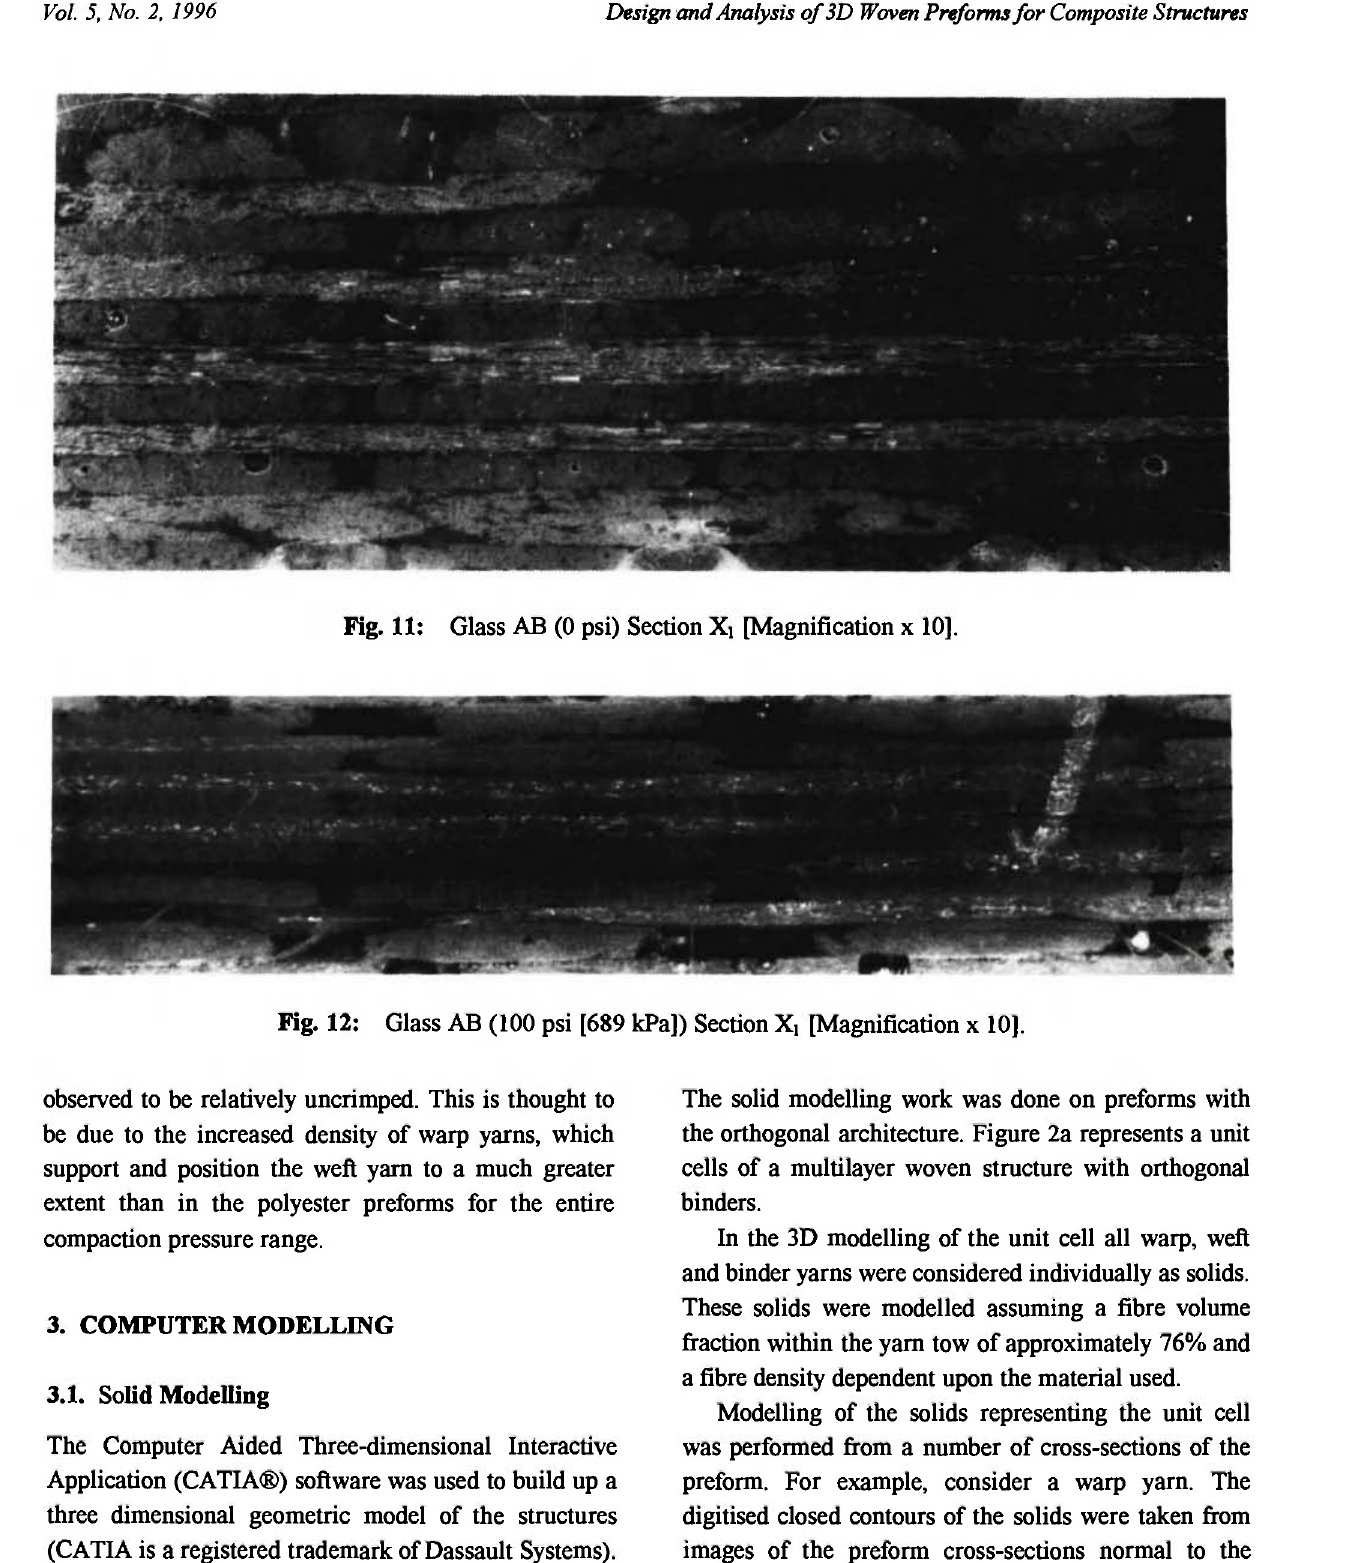
Fig. 11: Glass AB (0 psi) Section X, [Magnification χ 10],